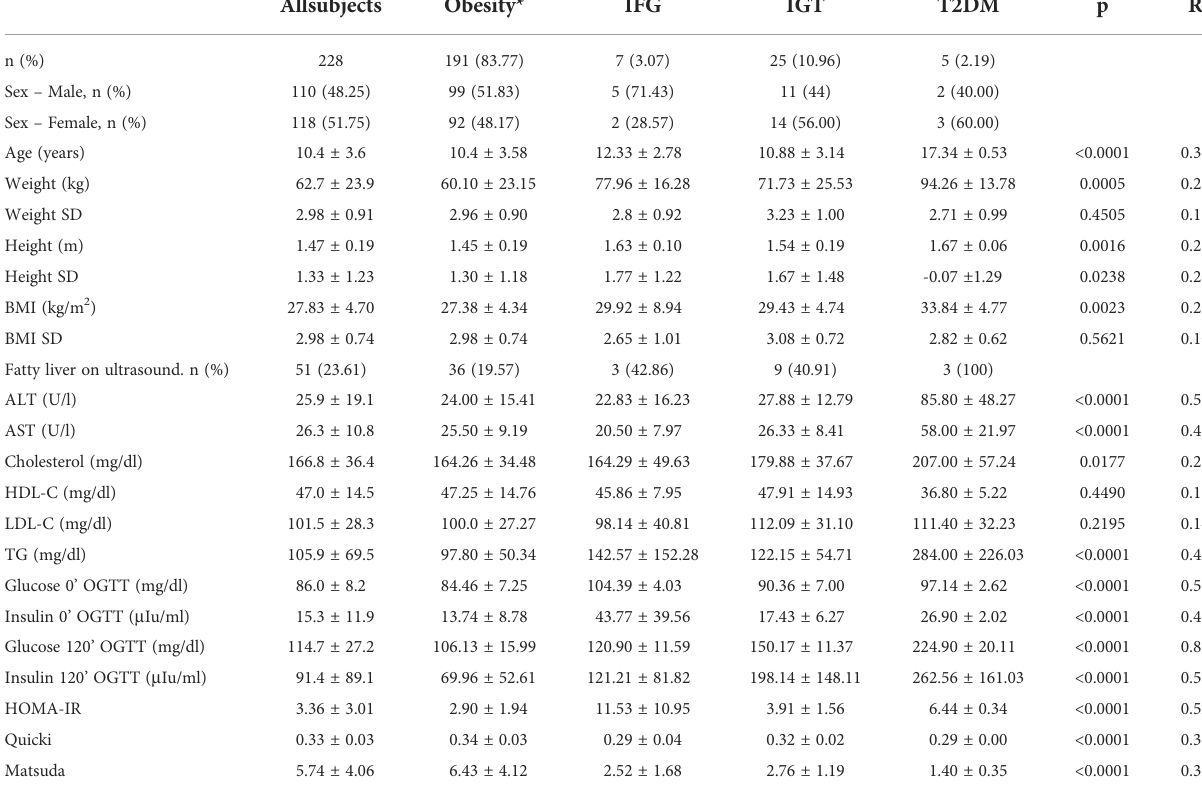
TABLE 1 Subjects characteristic by glucose tolerance